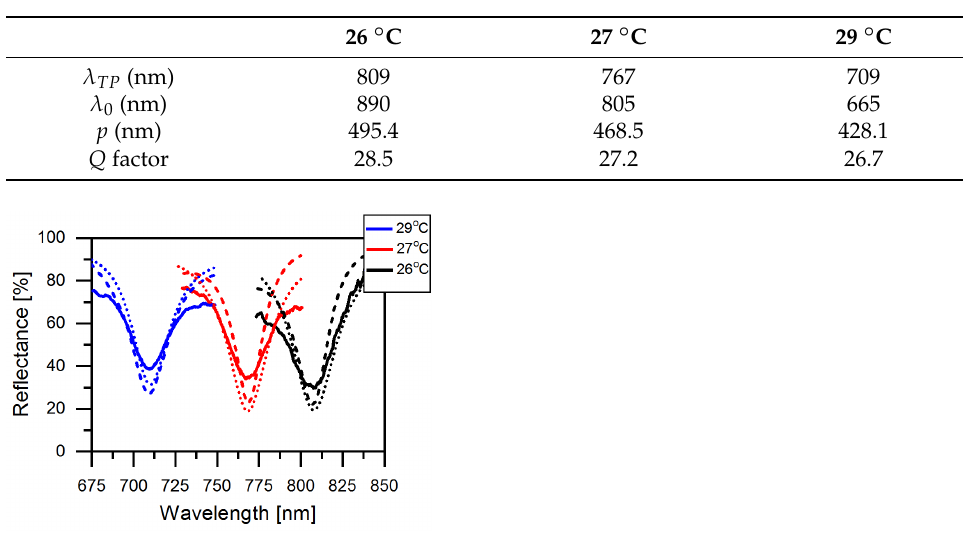
Table 1. Tunability of the resonant wavelength of chiral-selective TPP ( λ TP ), center wavelength of CLC stopband ( λ 0 ), pitch p and Q factor of the TPP with respect to the different temperatures.